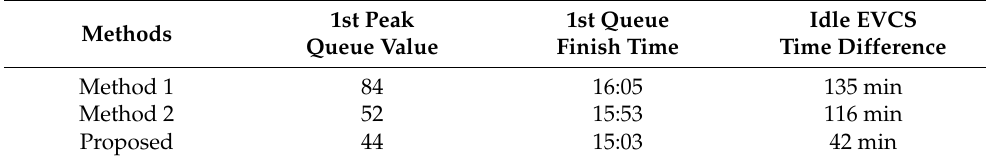
Table 4. Peak number of queuing vehicles, finish queuing time, and idle time difference comparison.